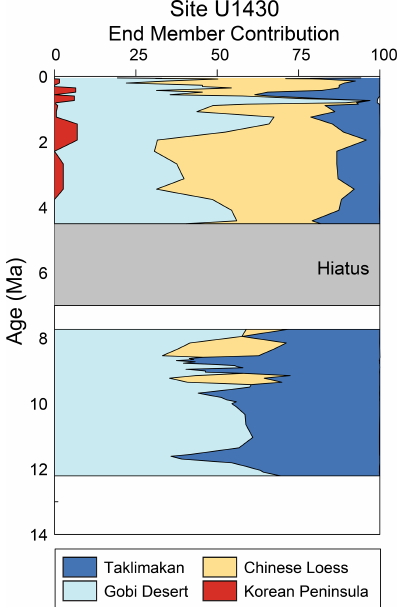
Figure 8. Aluminosilicate contribution (wt% of aluminosilicate in- ventory) at Site U1430 through time. The end-member contribu- tions are plotted as the total sum, with each color representing the sum of the specific end-member plus the end-members to the left. The shaded region denotes a hiatus, and the following box notes a period in which we did not overinterpret our data to fill the temporal gap between the end of the hiatus and the start of our Miocene-aged samples. From Anderson et al.